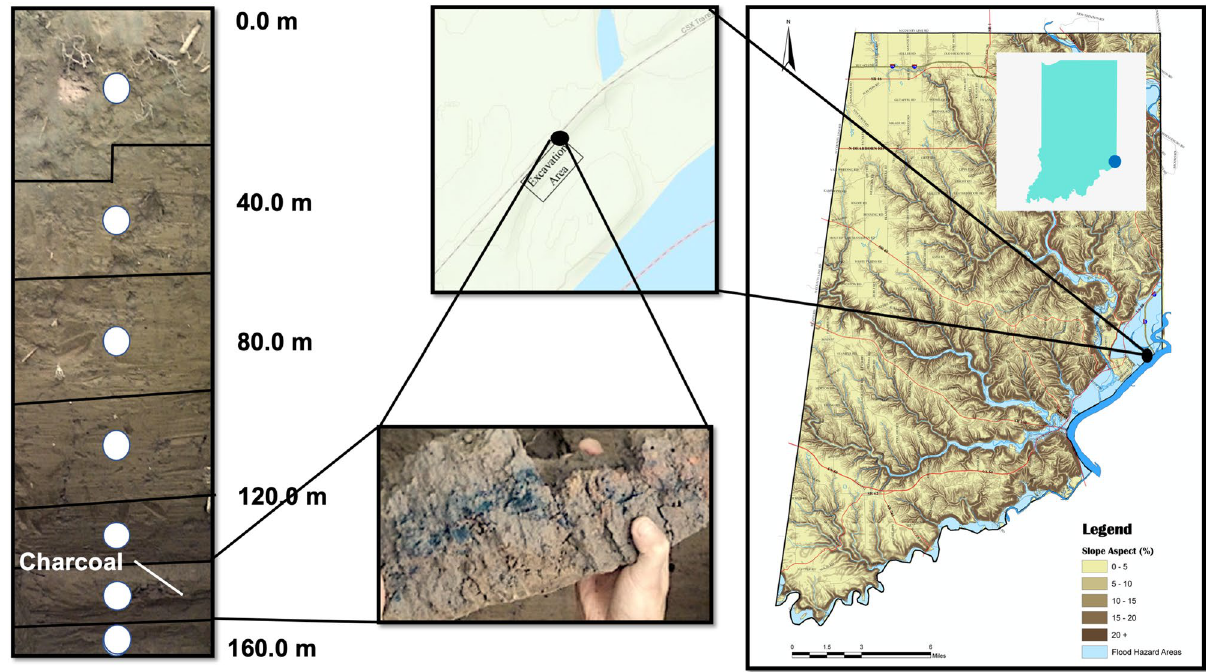
Figure 4. The location, stratigraphy, and sediment sample sites (white circles) of the Jennison-Guard village site, Dearborn County, Indiana. Kenneth Barnett Tankersley used Microsoft PowerPoint for Mac Version 16.41 (www. micro soft. com) to create this figure. The GIS map was produced in ESRI ArcGIS 10.3.1 software (www. esri. com).